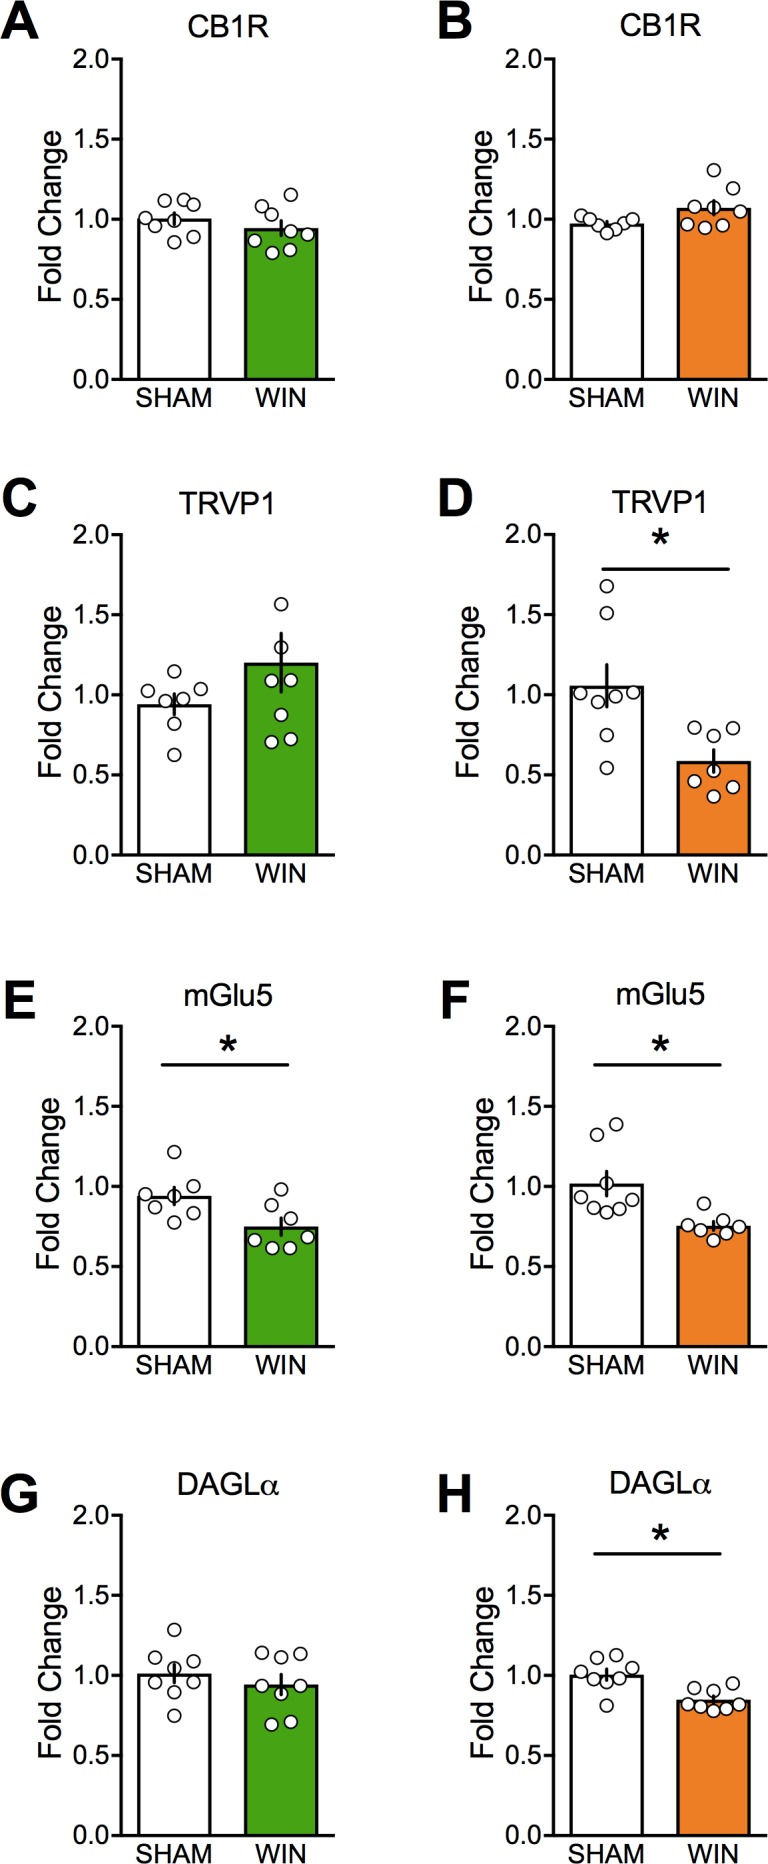
Prenatal cannabinoid treatment affects expression of endocannabinoid system components in a sex-dependent fashion.CB1, TRPV1, mGlu5, and DAGLα mRNA levels in medial prefrontal cortex at PND90 were determined by real-time PCR in male (A, C, E, and G) and female (B, D, F, and H) rats using Taqman probes and a QuantStudio7 thermocycler. Treatment of dams with WIN from GD5 to GD20 decreased TRPV1, mGlu5, and DAGLα mRNA in female offspring. However, the same treatment decreased only mGlu5 in male offspring. *p<0.05. Error bars represent SEM.